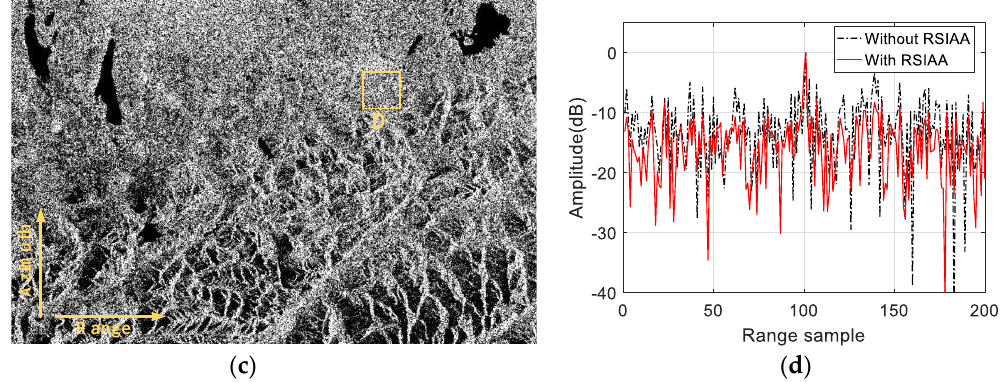
Figure 17. Imaging results of the second set of Sentinel-1 SAR data. ( a ) The SAR image with RFI; ( b ) the SAR image without the RSIAA; ( c ) the SAR image with the RSIAA; ( d ) range profiles of the target in area D.